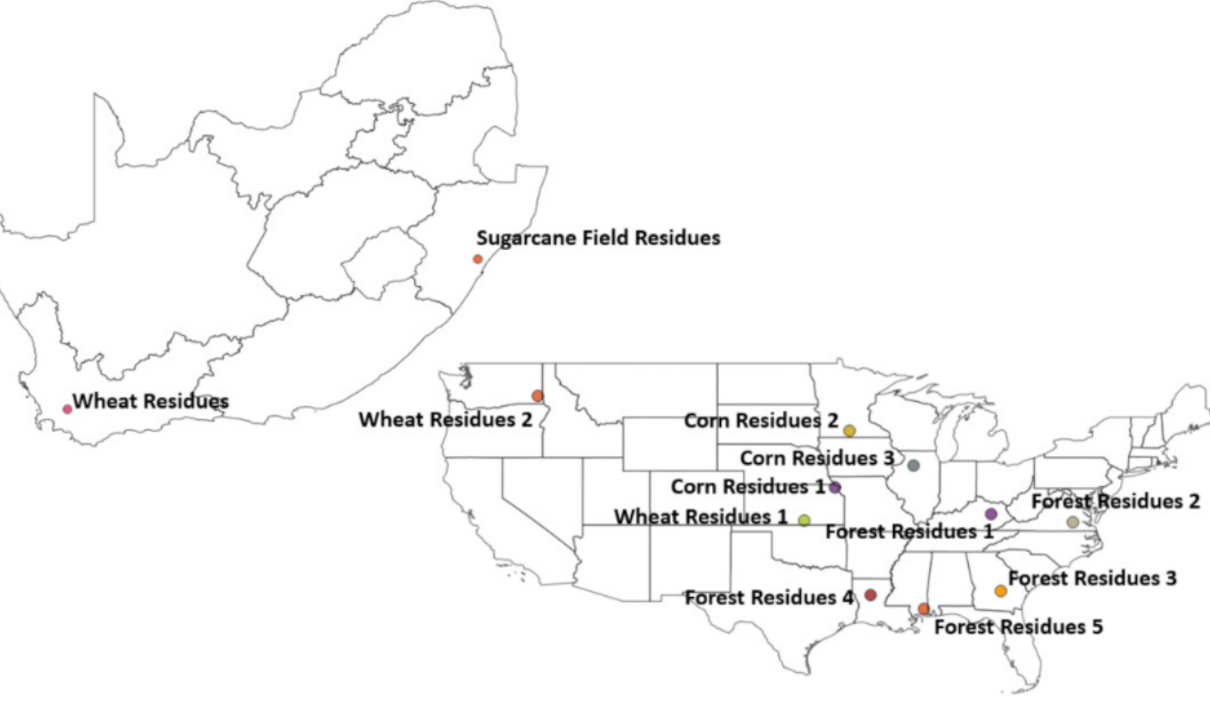
Figure 9. Biomass residues hotspots in South Africa (right) and US